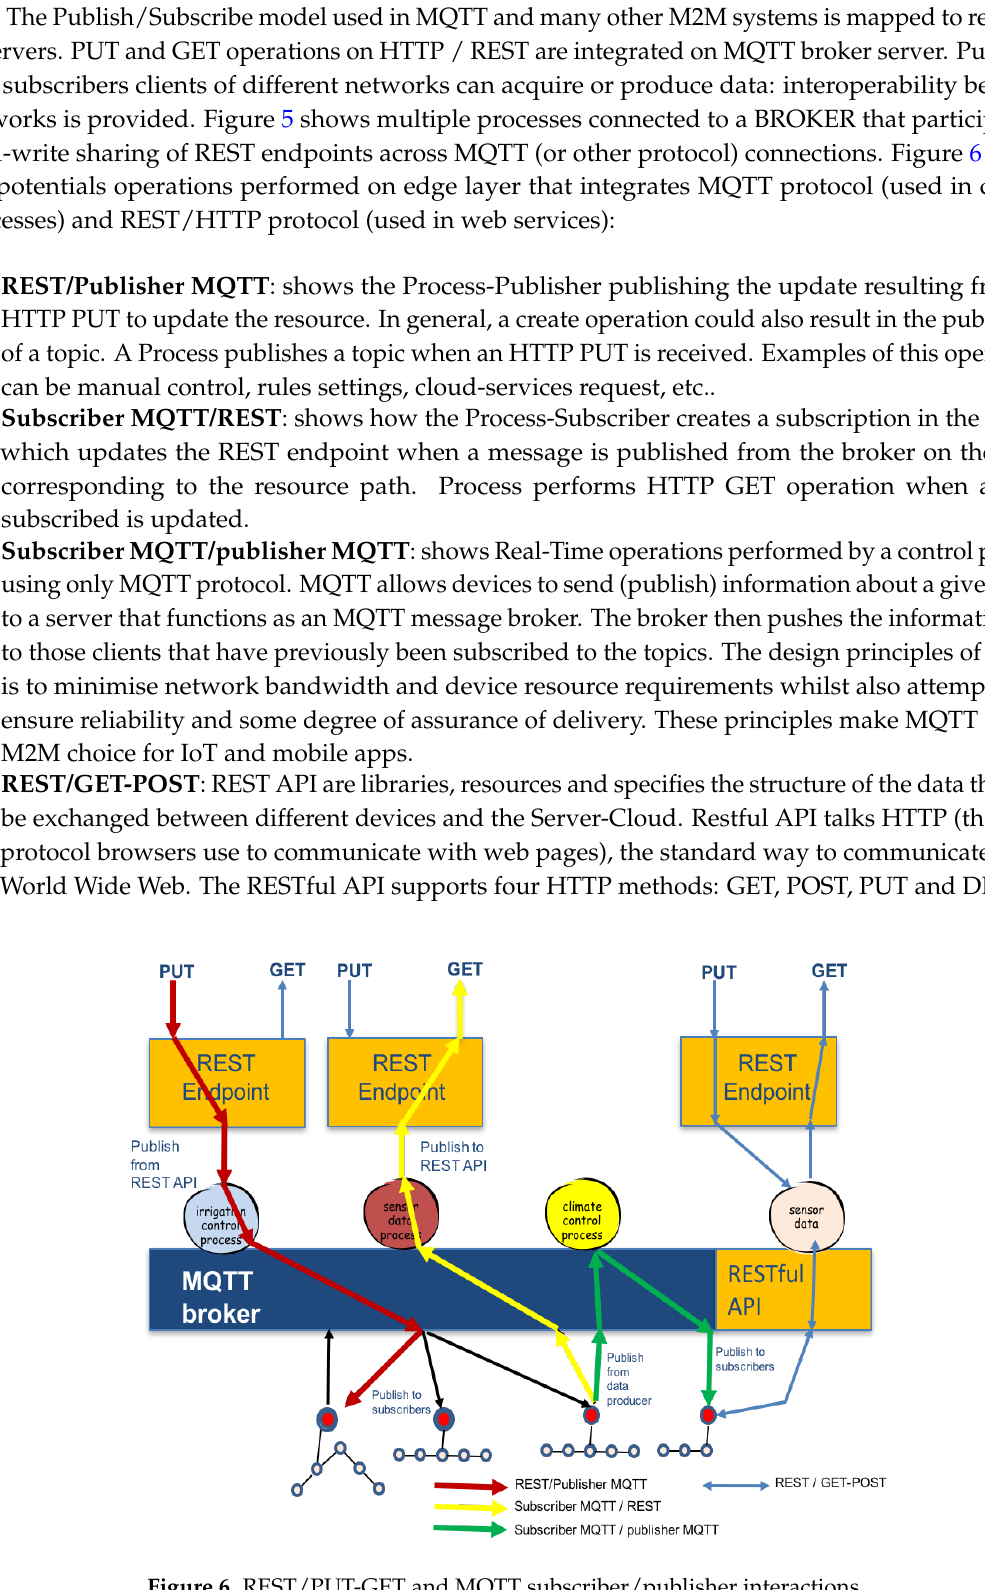
Figure 6. REST/PUT-GET and MQTT subscriber/publisher